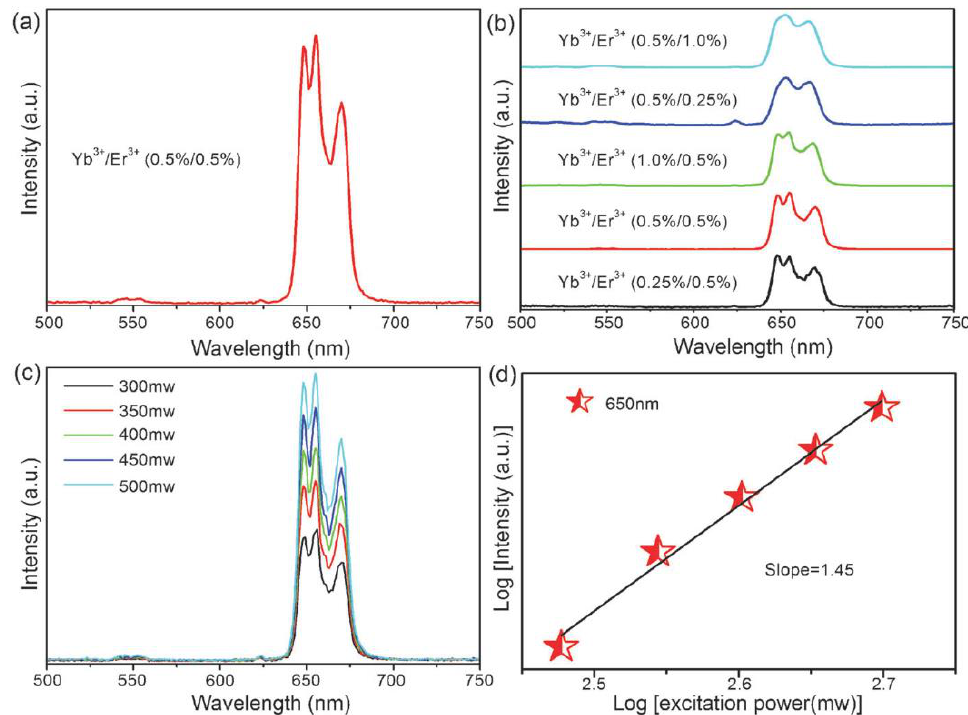
Figure 3. UC properties of KMgF 3 :Yb 3+ , Er 3+ UCNCs. ( a ) A spectrum of single-band red UC emission; ( b ) UC emission spectra with various doping concentrations; ( c ) UC emission spectra with various excitation powers; ( d ) the corresponding logarithmic plot between UC intensity and excitation power. Reprinted with permission [62]. Copyright 2016, Royal Society of Chemistry.